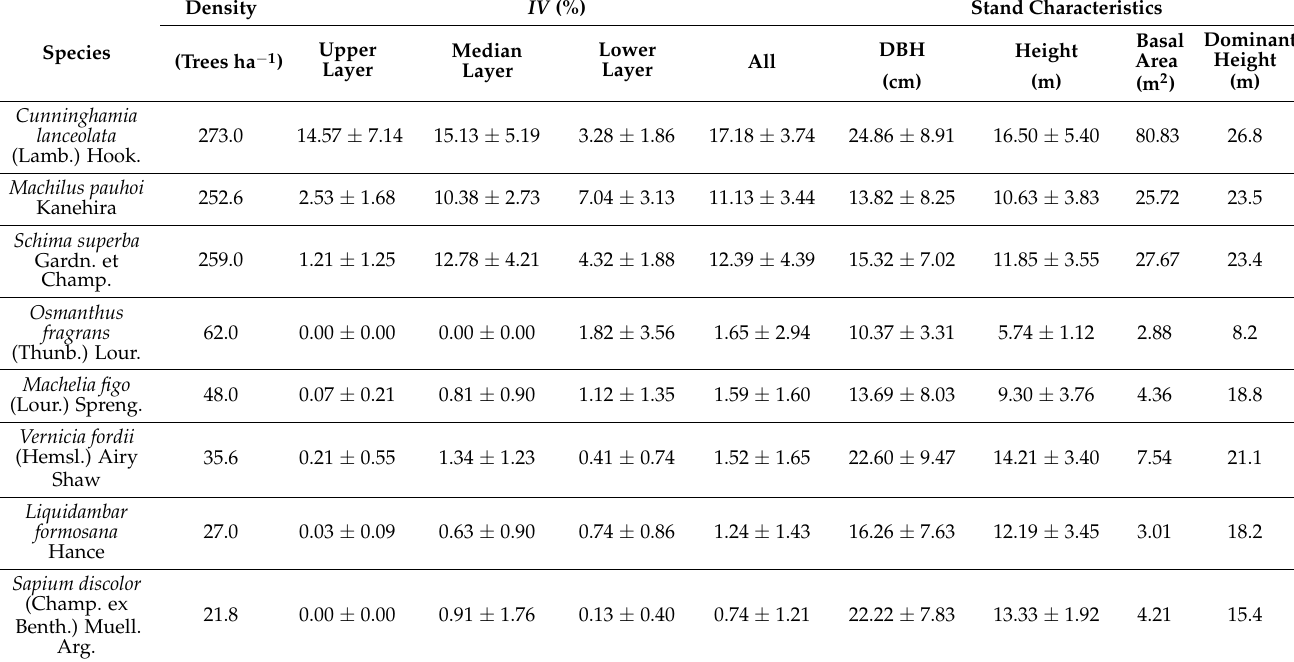
Table 1. IV and characteristics of eight dominant tree populations in the planted mixed